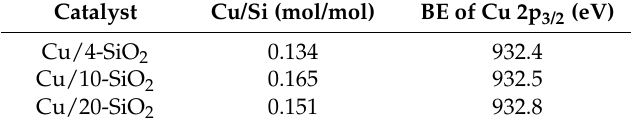
Table 2. X-ray photoelectron spectroscopy results of reduced Cu/ x -SiO 2 catalysts.